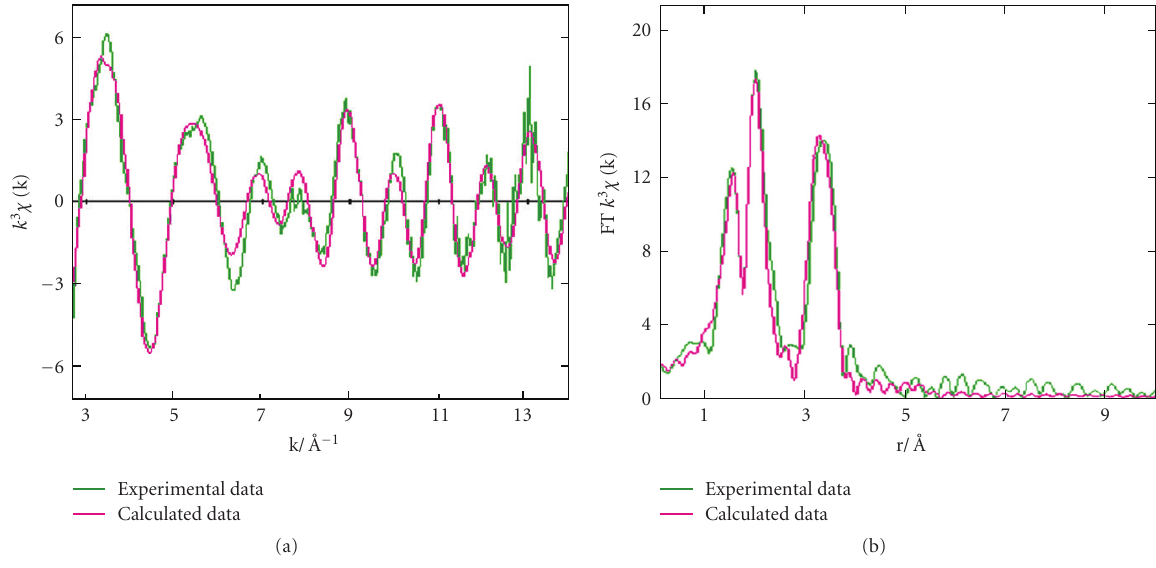
Figure 7: NbK-edge X-ray absorption data. (a) EXAFS spectra, and (b) Fourier transform data for Nb-Fbp (prepared from 10:1 [Cp 2 Nb(OH)Cl 2 ] : apoFbp reaction). Green line : experimental data; red line: calculated